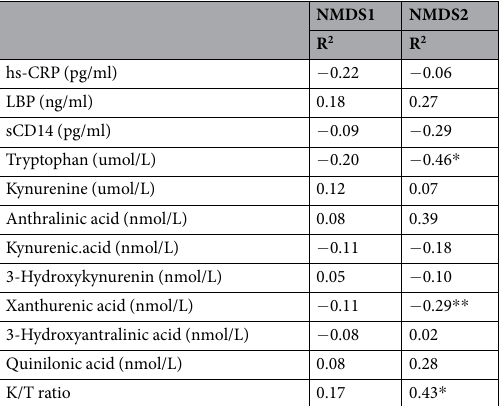
Table 3. Correlation strengths (R 2 ) for each NMDS axis/marker. * Indicates p-value < 0.01. ** Indicates p-value <